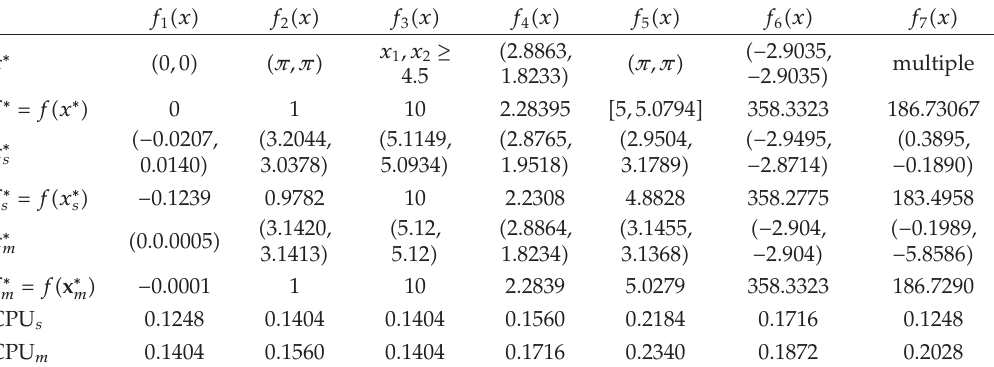
Table 1: Summery of simulation results, with maximum number of iterations as a termination criterion.